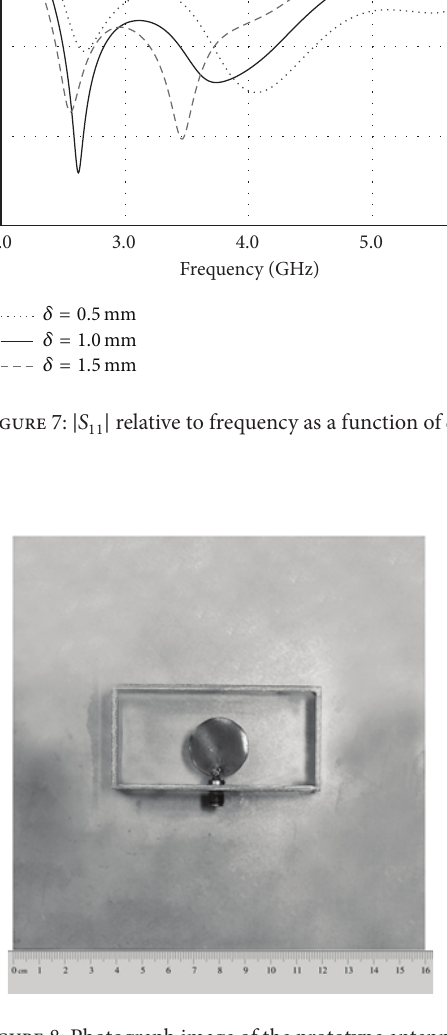
Figure 10: The simulated and measured gains relative to